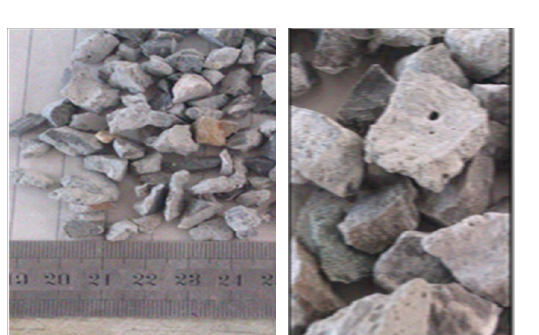
Fig.1: Natural Aggregates (NA)